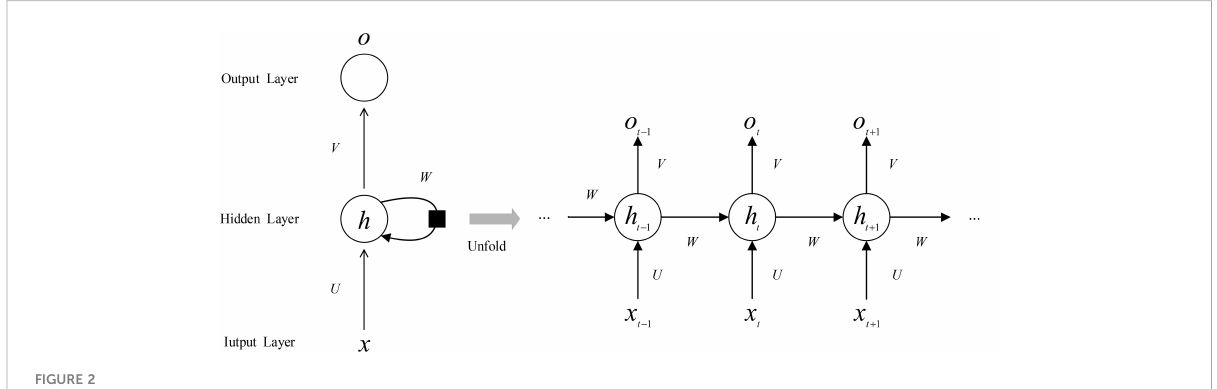
FIGURE 2 RNN module